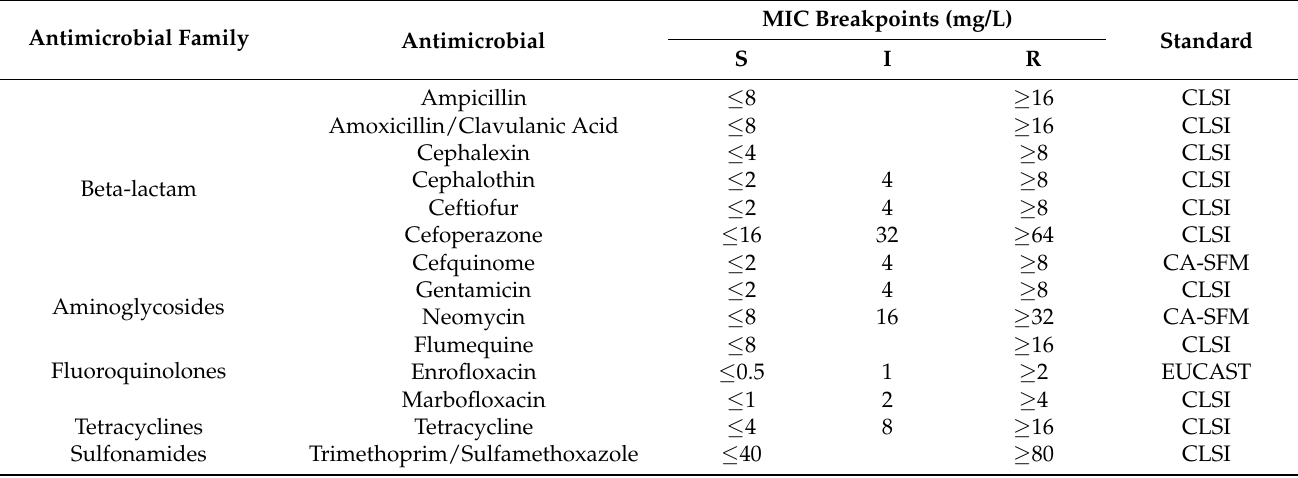
Table 1. Antimicrobials tested, with the minimum inhibitory concentration (MIC) breakpoints and international Standard used for each